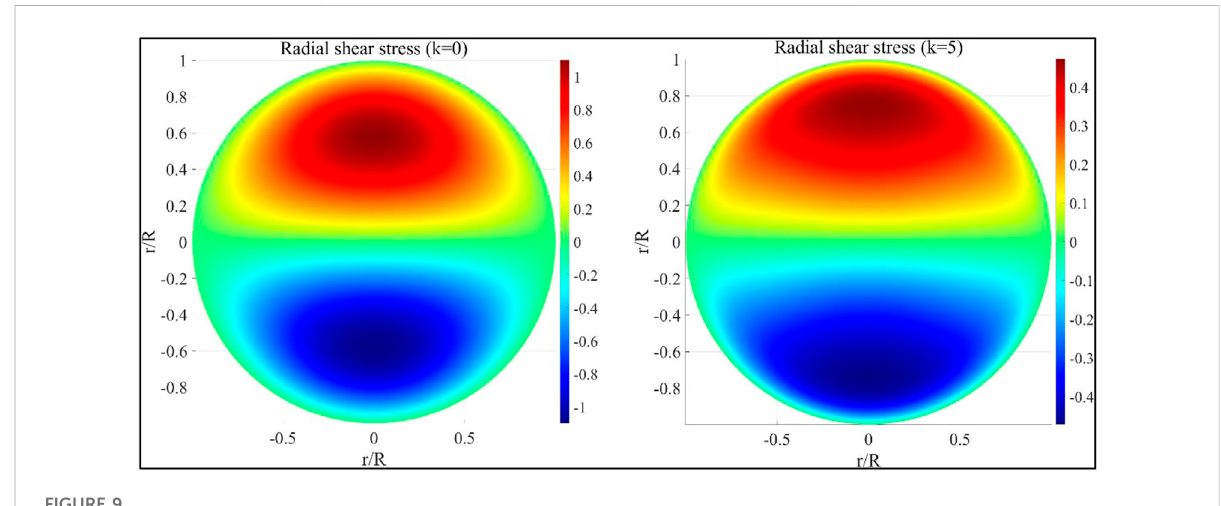
FIGURE 9 The non-dimensional radial shear stresses for k = 0 and k =